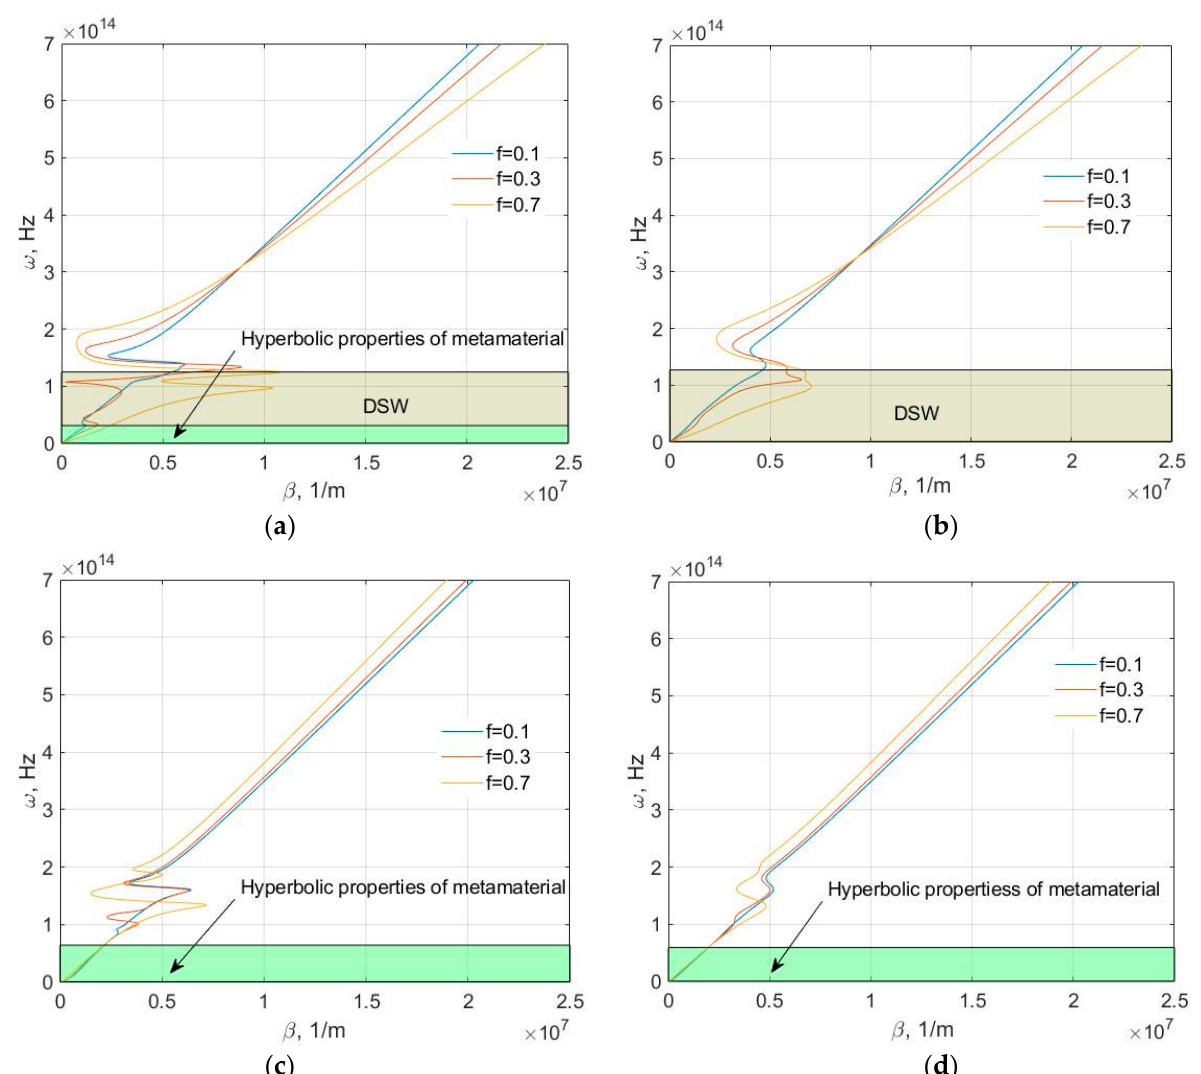
Figure 3. Solution of the wave equation for different filling ratio f : ( a , b )— ε n = 2.25, ε d = 11.8; ( c , d )— ε n = 11.8, ε d = 2.25. Herein AZO ( a , c ) and ITO ( b , d ) inclusions are employed in nanocomposite and